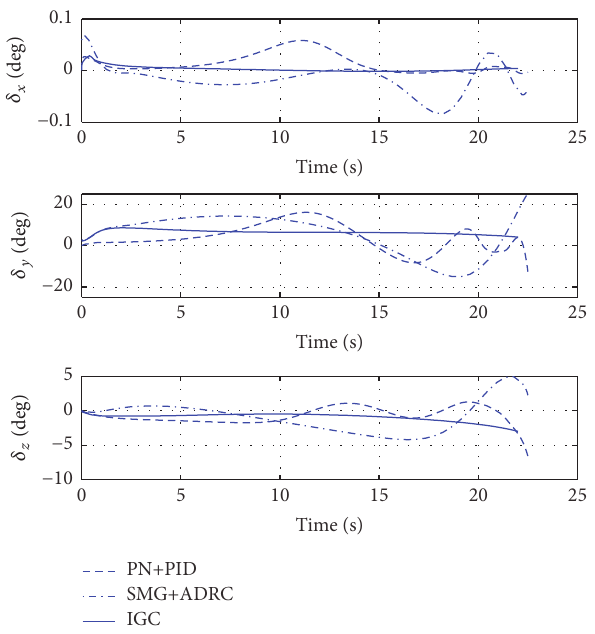
Figure 10: The range of deflections of aerodynamic fins with respect to time in Scenario